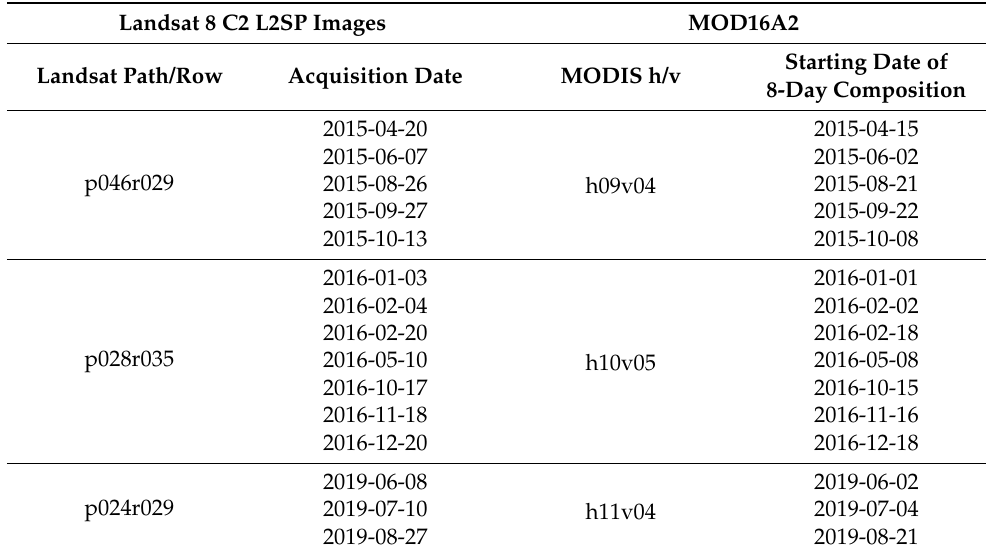
Table 1. The 15 Landsat 8 scenes and the corresponding MOD16A2 products for three study areas. The MOD16A2 is an 8-day composite and the starting date of the composite is